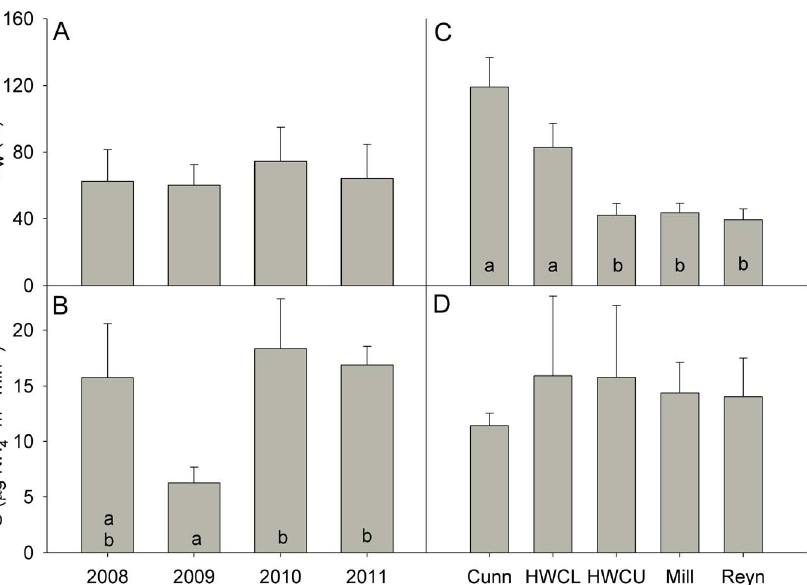
Figure 2. Nutrient uptake parameters in Coweeta streams. Changes in ammonium uptake length (S w ) and areal uptake (U) for low-order streams in Coweeta Hydrologic Laboratory over the years of the study (A–B) and in each stream (C–D). Error bars represent 1 SE of the mean, and different letters represent significant differences (p , 0.05) based on Wilcoxon post-hoc multiple comparison tests.